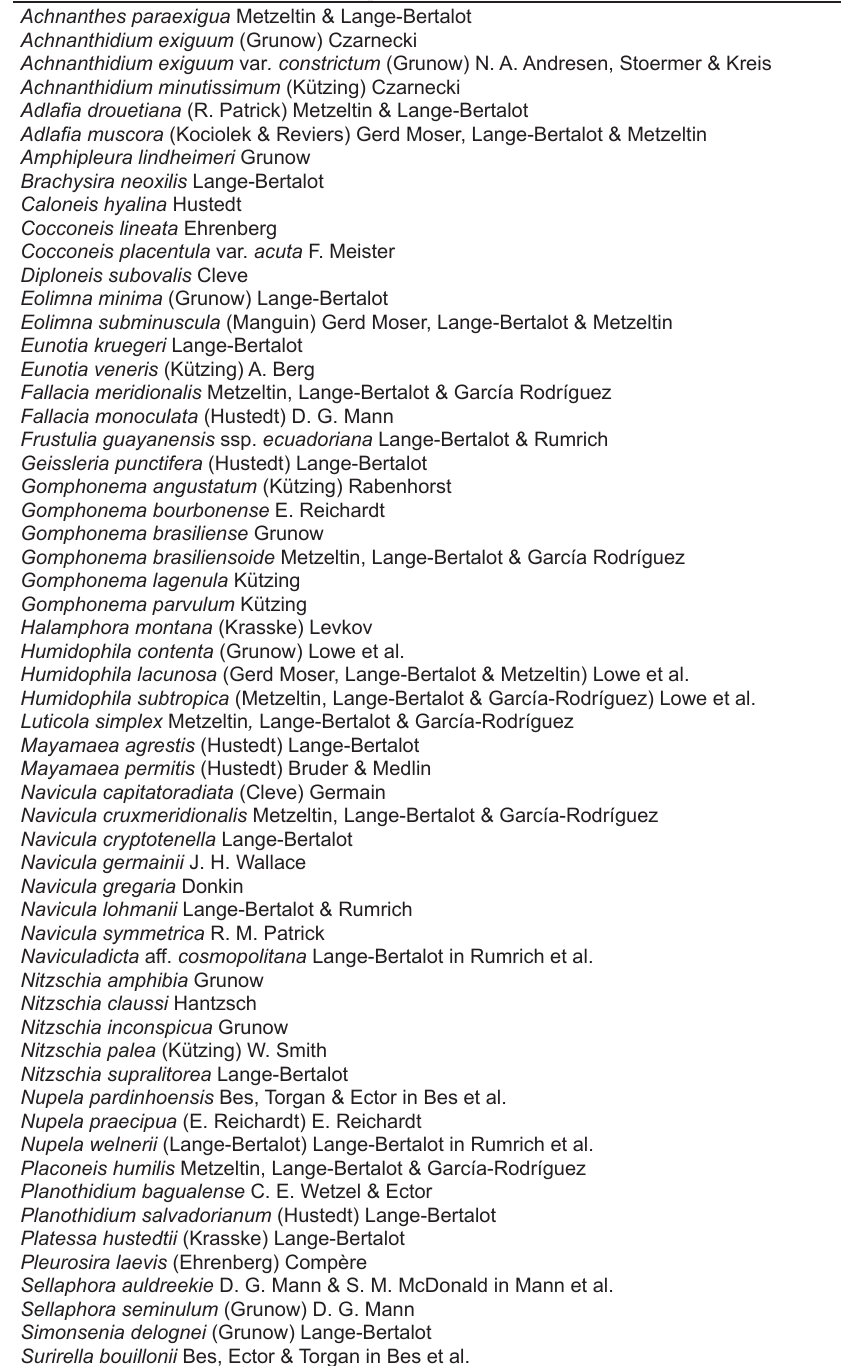
Table 1. List of the abundant diatom species in the Andreas Stream Sub-basin, RS,